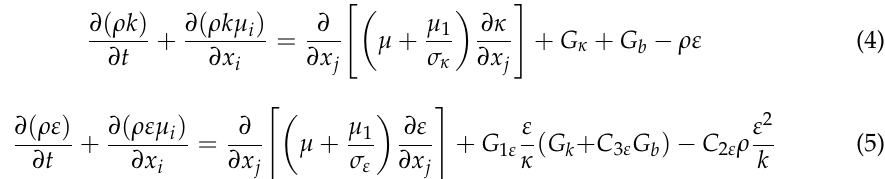
Figure 5. Simplified diagram of ventilation in the station during the non-air-conditioning season. The airflow organization pattern in the station can be simplified to the following two states [23,24], one is the PSDs closed state (Figure 6a); when the train does not arrive, if the air leakage of PSDs are neglected, PSDs are well-sealed and the air inside the subway flows to the outdoor through the exits. The particulate matter generated in the tunnel by the train running and rubbing the track will not enter the platform [23]; the other one is the PSDs opened state (Figure 6b), since the low air pressure in the tunnel and carriages, the platform air flows to the tunnel and carriages. Meanwhile, the outdoor air enters the concourse floor. When PSDs are closed, the sources of particulate are air supply outlets, equipment, and pedestrians; but when the PSDs are opened, outdoor air enters so that the exits are also particulate sources, therefore, the two airflow organization states need to be simulated separately. ( a ) ( b ) Figure 6. Two main airflow organization states: ( a ) PSDs closed; ( b ) PSDs opened. Table 3 summarizes the boundary condition settings of this CFD simulation model, including the concourse/platform floor air supply velocity v c / v p , the value of lighting load